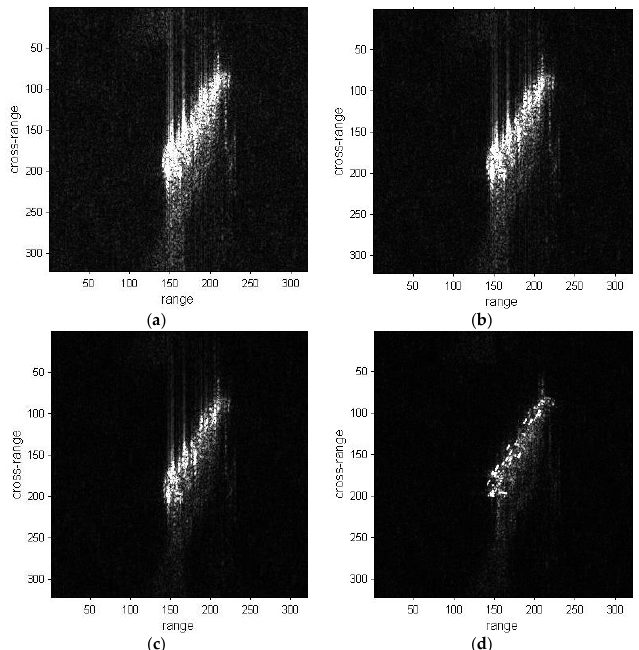
Figure 6. Refocused images of the ship01 sub-image. ( a ) Sub-image of ship01; ( b ) Refocused image with the DCT method; ( c ) Refocused image with the PGA method; ( d ) Refocused image with the proposed method.